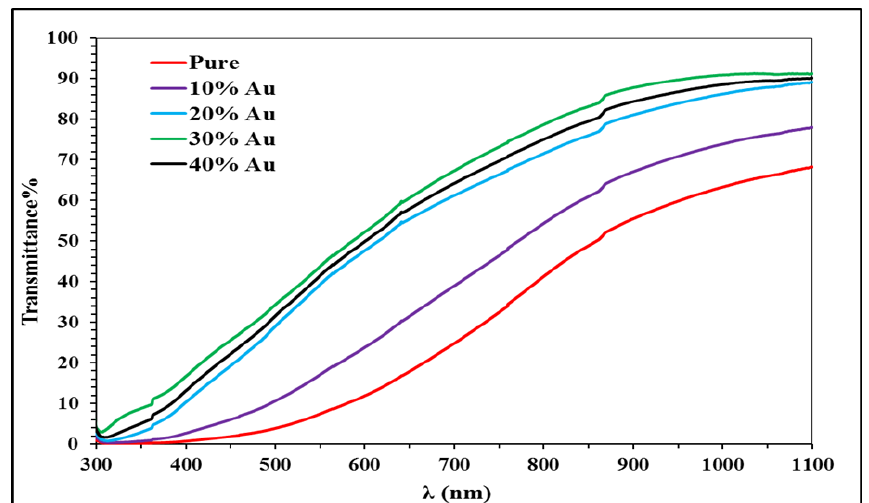
and doped of Au (0, 10, 20, 30 and 40)% 3